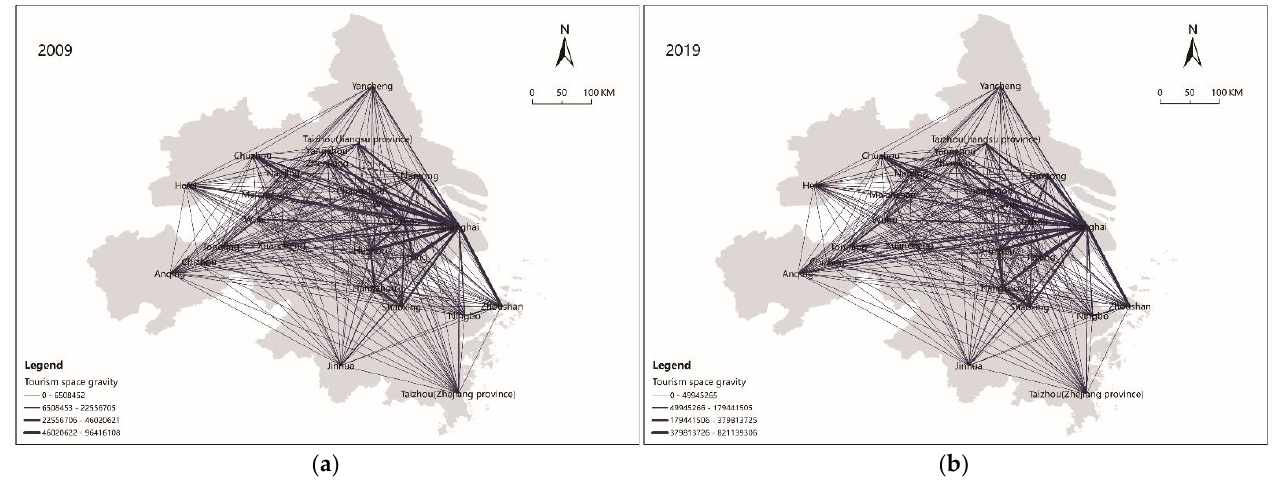
Figure 2. Spatial correlation network of tourism eco-efficiency in ( a ) 2009 and ( b ) 2019. The degree of network correlation was used to measure the closeness of the connections between the different city nodes in the spatial correlation network. From 2009 to 2019, the network connectivity of the spatial correlation network of tourism eco-efficiency in 26 cities was one, indicating that all the cities were connected. The spatial correlation network structure performed well in terms of its connectivity, accessibility, and robustness (Figure 3).